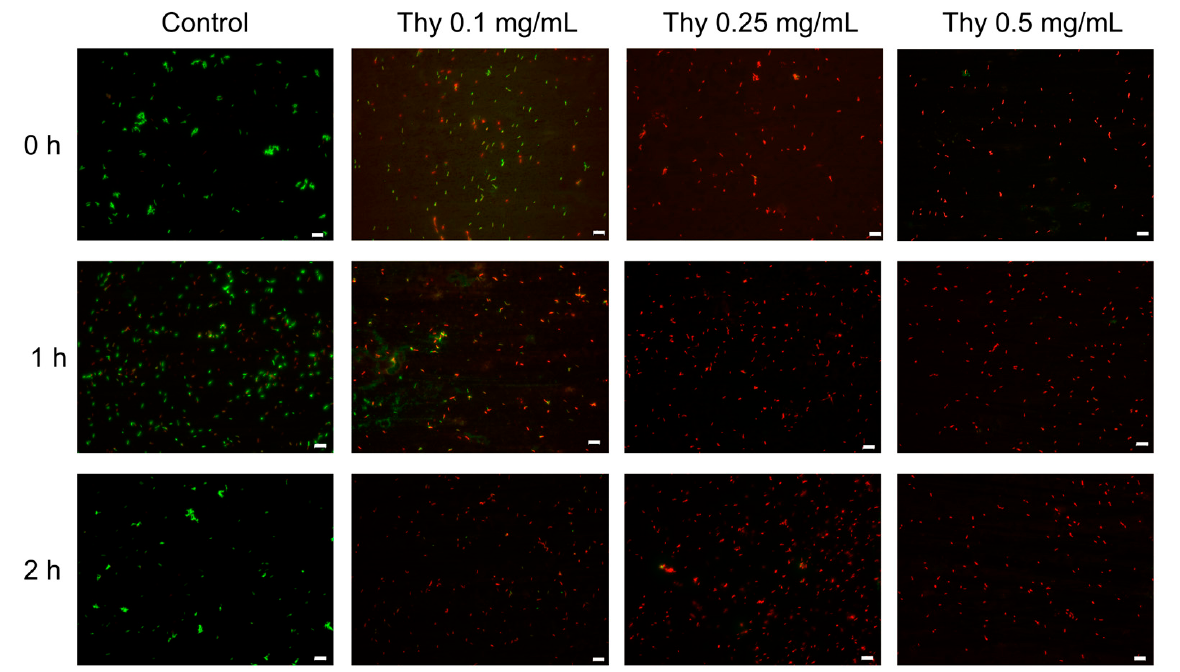
Figure 3. Fluorescence microscopy images of XfDD cells in water suspensions after 0–1–2 h of exposure to thymol solutions at 0.1–0.25–0.5 mg/mL. The control is non-treated cells. Scale bar is 10 µ m. Representative images from three experiments.